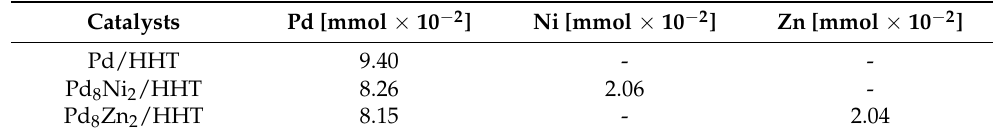
Table 9. Summary of the amount of the metals for the preparation of the sol.